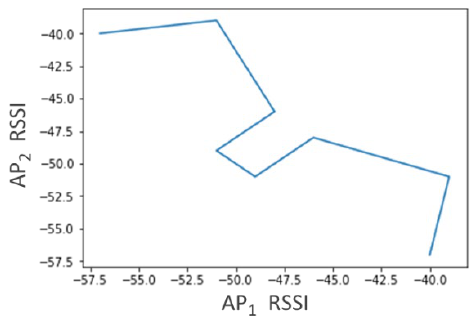
Figure 13. RSSI distribution of AP 2 vs. that of AP 1 To verify this inference, we take 800 RSSI sample sets (100 sample sets in each 8 observation points) as showed in Figure 12.The two-dimensional RSSI data wereseparated into training/testing sets with 80 : 20 ratio ( 640 training sets and 160 testing sets) and training sets were input to an ANNwith the same structure as that de- scribed above. The network was found to converge with an accuracy approaching 99.58% after 200 training epochs. Having trained the model, 160 RSSI samples were used for testing purposes. Table 3 shows the result- ing confusion